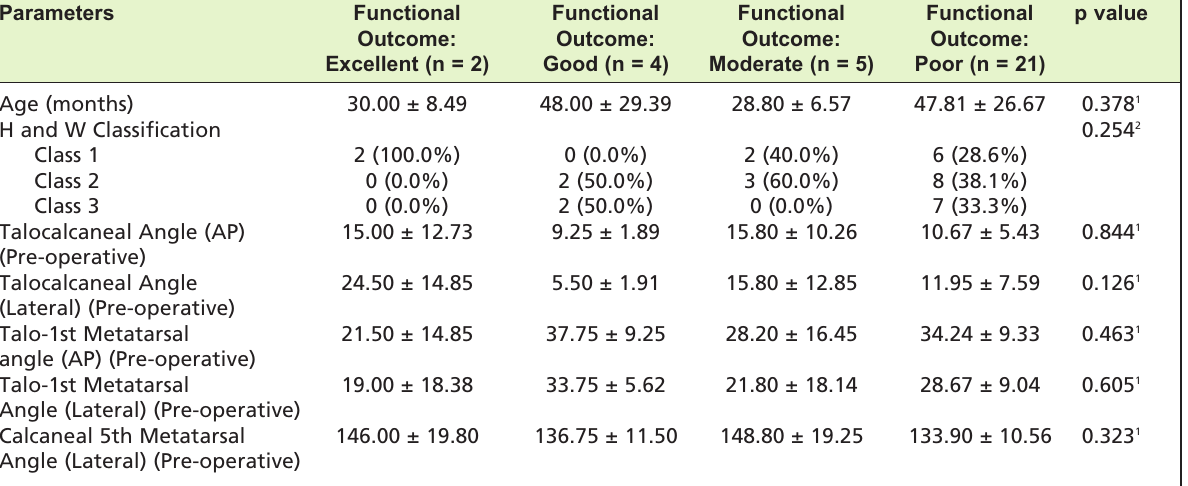
Correlation of the Ponseti Laaveg functional score with age, pre-operative classification and pre-operative Table V: radiographic angles